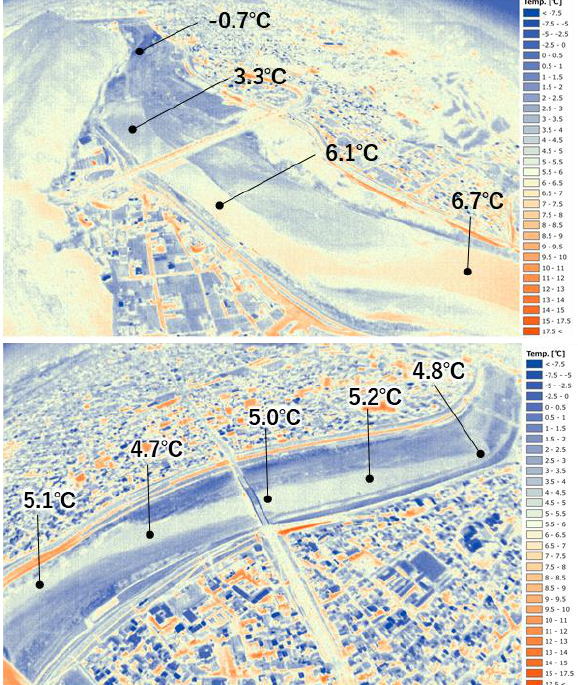
Figure 4. Thermal infrared camera images captured with the wide-angle lens. Upper: case of small shooting depression angle, lower: case of large shooting depression